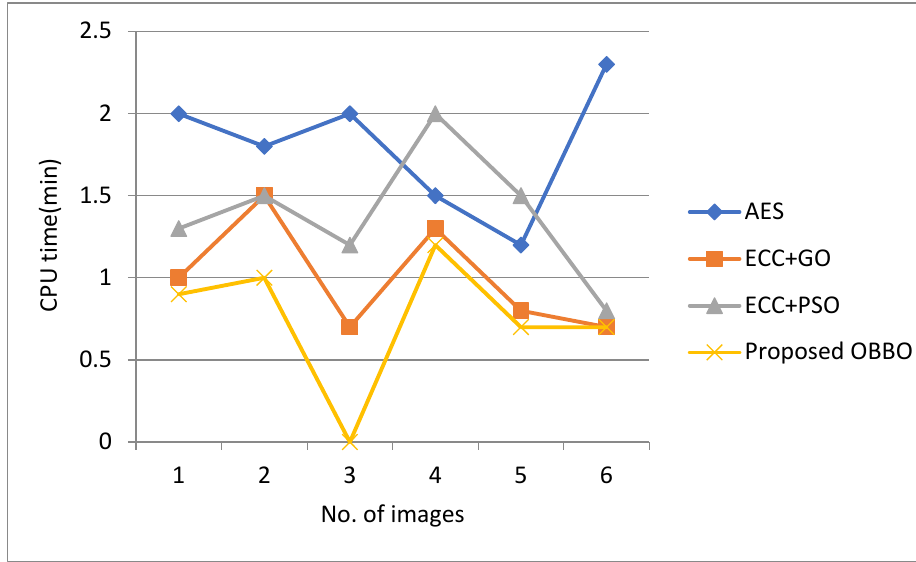
Figure 6. Fitness comparison with existing algorithms.